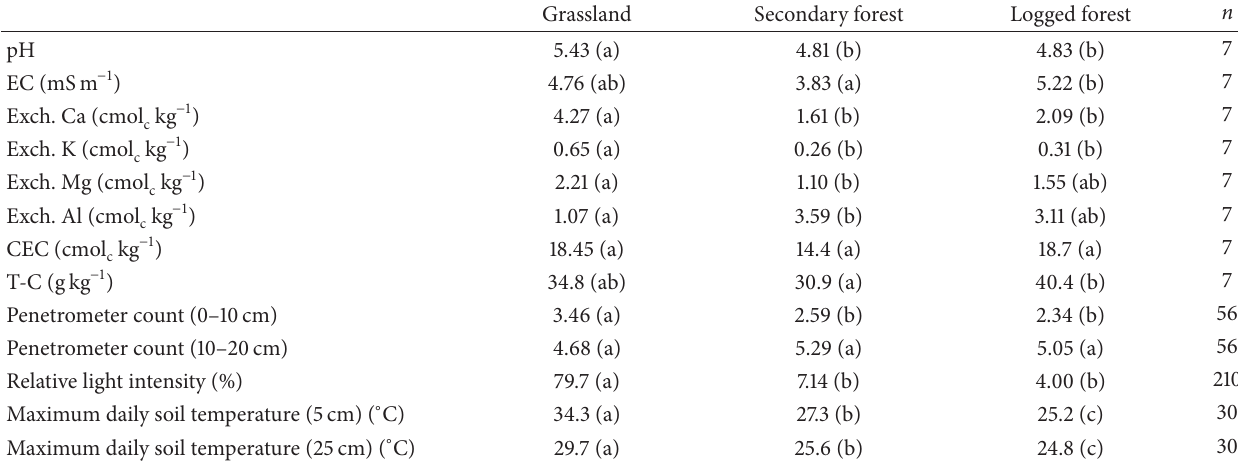
Table 1: Differences in surface soil properties and relative light intensities in the grassland, secondary forest, and logged forest. Grassland Secondary forest Logged